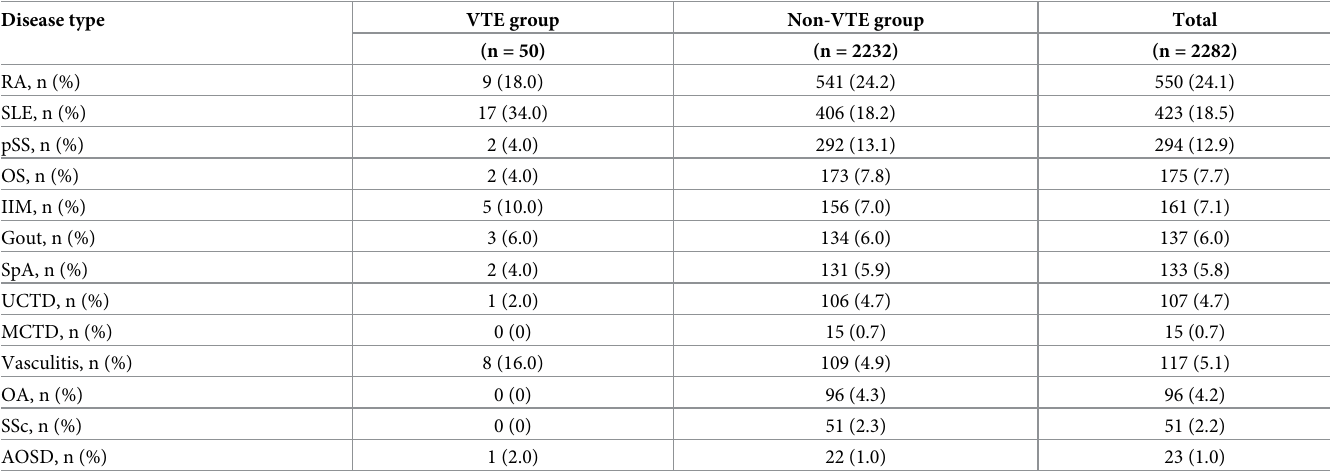
Table 1. The disease distribution in the VTE and non-VTE groups (n = 2282). Disease type